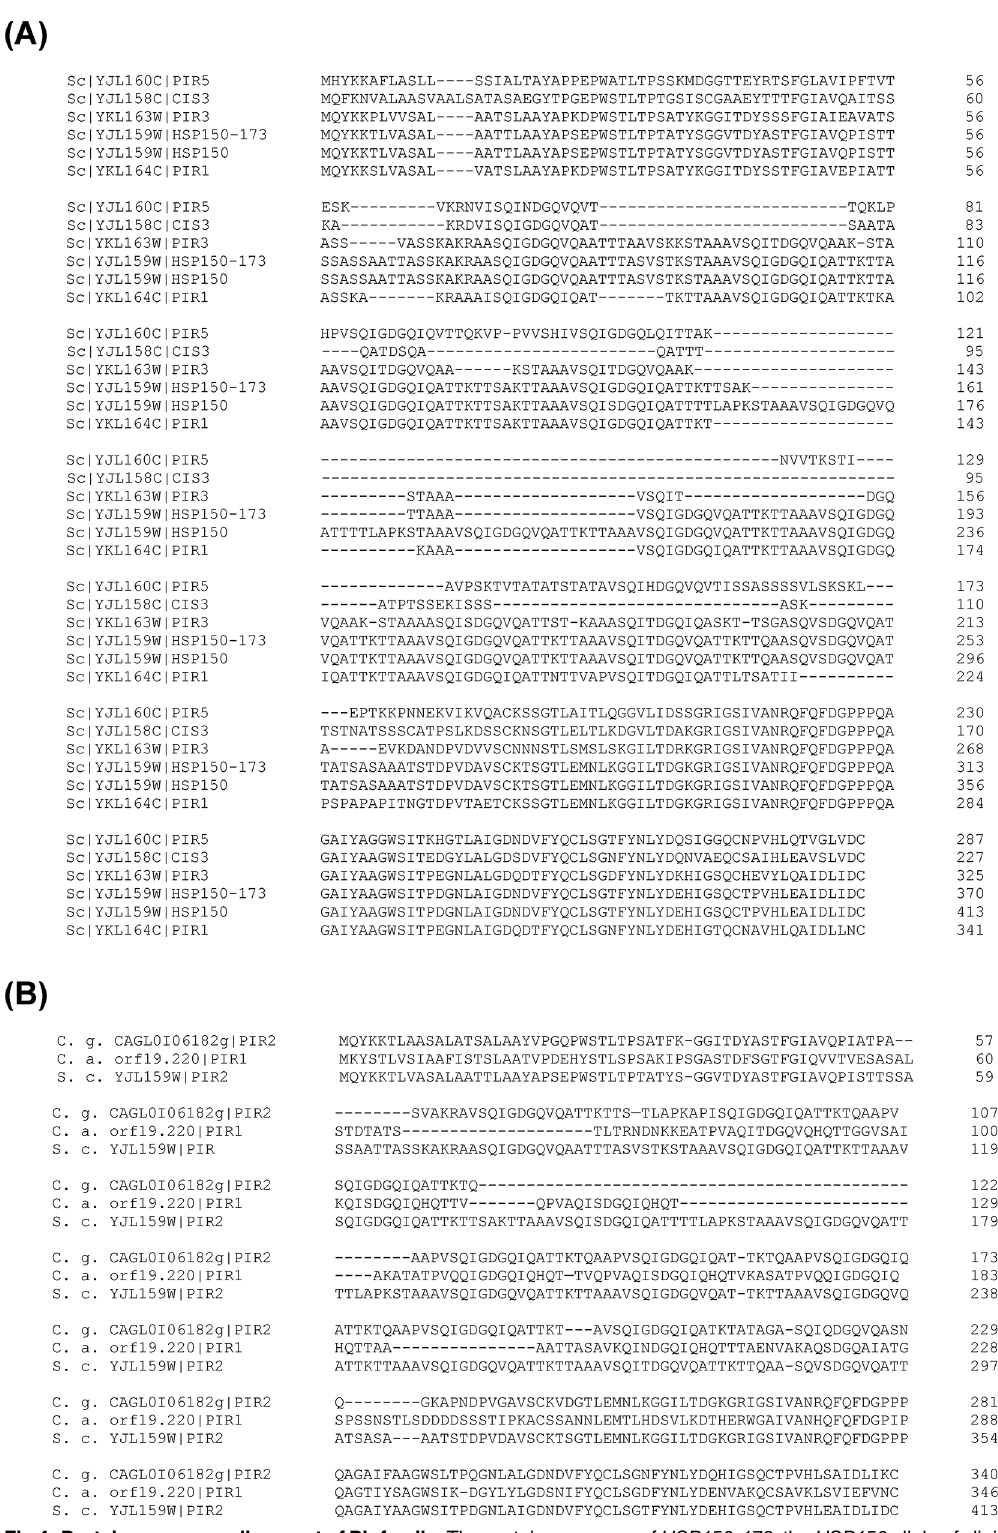
Fig 4. Protein sequence alignment of Pir family. The protein sequence of HSP150-173 , the HSP150 allele of clinical isolate YYC173, was deduced from its DNA sequencing results. (A) Pir family protein sequences of Pir1p, Hsp150p, Pir3p, Cis3p, and Pir5p from lab strain S288c, extracted from Saccharomyces Genome Database, together with Hsp150-173 were aligned. (B) Hsp150p/Pir2p protein orthologous sequences of Candida albicans (C . a . )